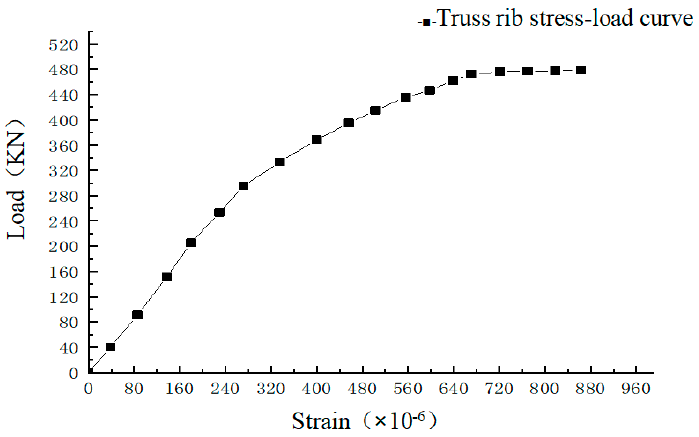
Figure 37. Truss rib stress − load curve.